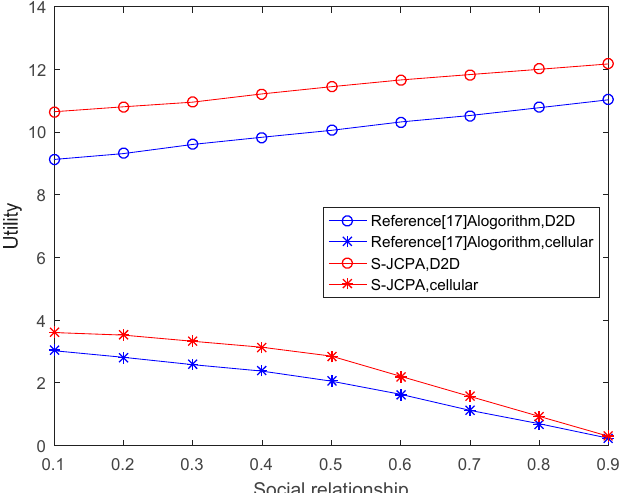
Figure 5. D2D and cellular’s utility for di ff erent algorithms with di ff erent social relationships, M = 20, N = 5 .